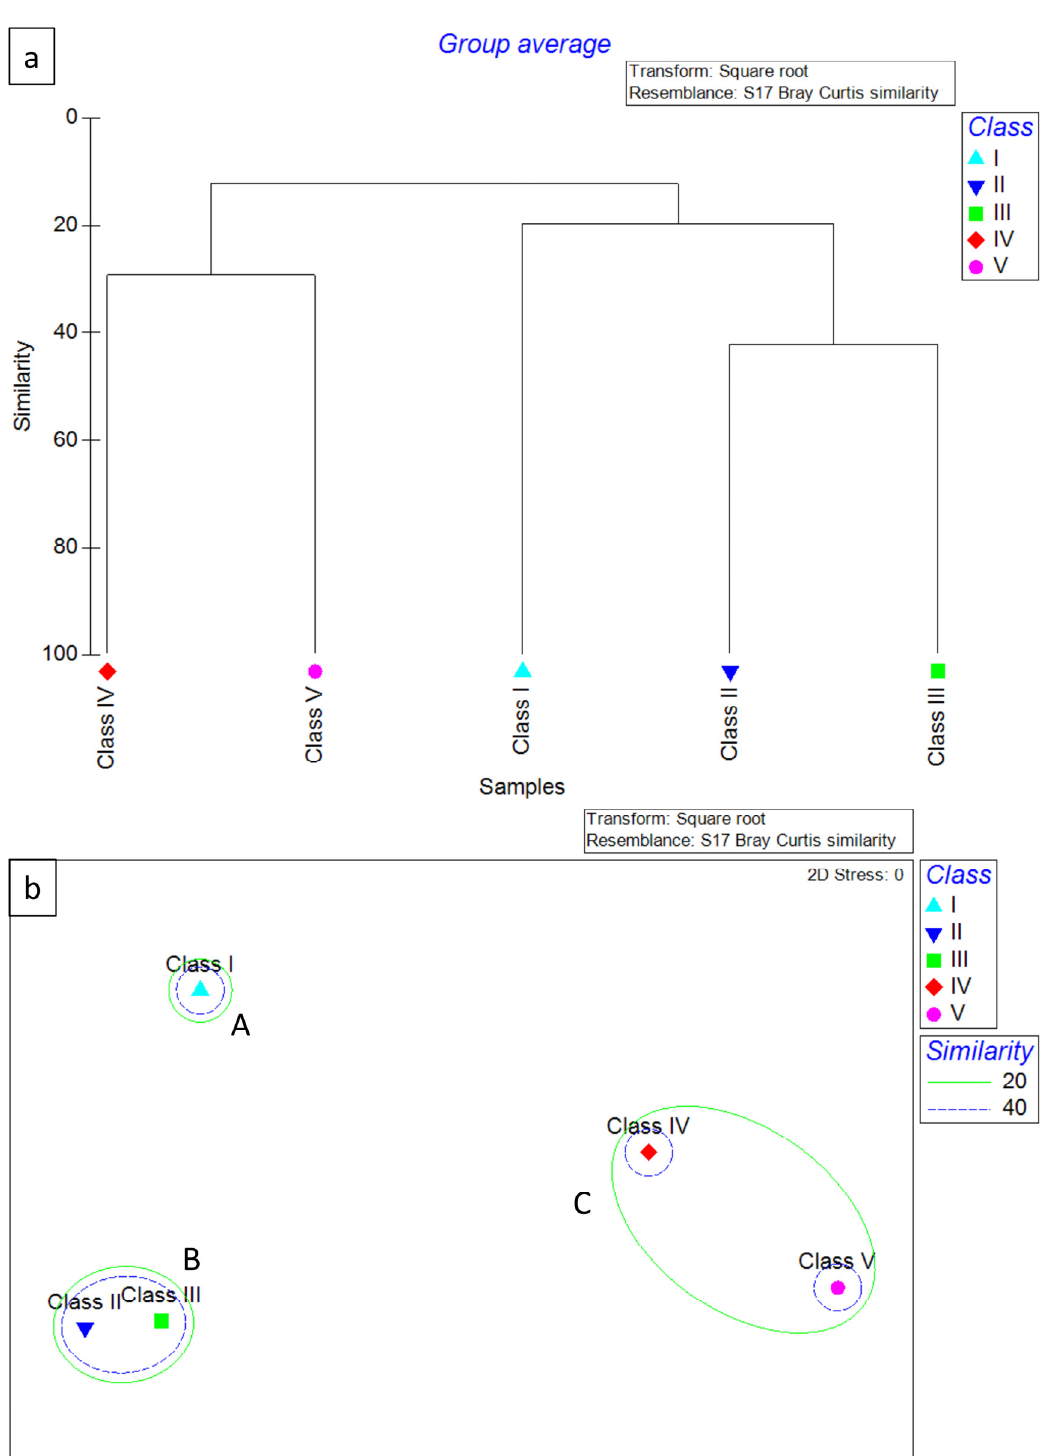
Figure 9. Dendrogram ( a ) and MDS ordination of Bray–Curtis similarities ( b ) from dietary data (square root transformation) for the 5 hake classes analyzed in 2020. Cluster A included only the specimens belonging to Class I, cluster B included the specimens belonging to Classes II and III while the third one (cluster C) included Classes IV and V.